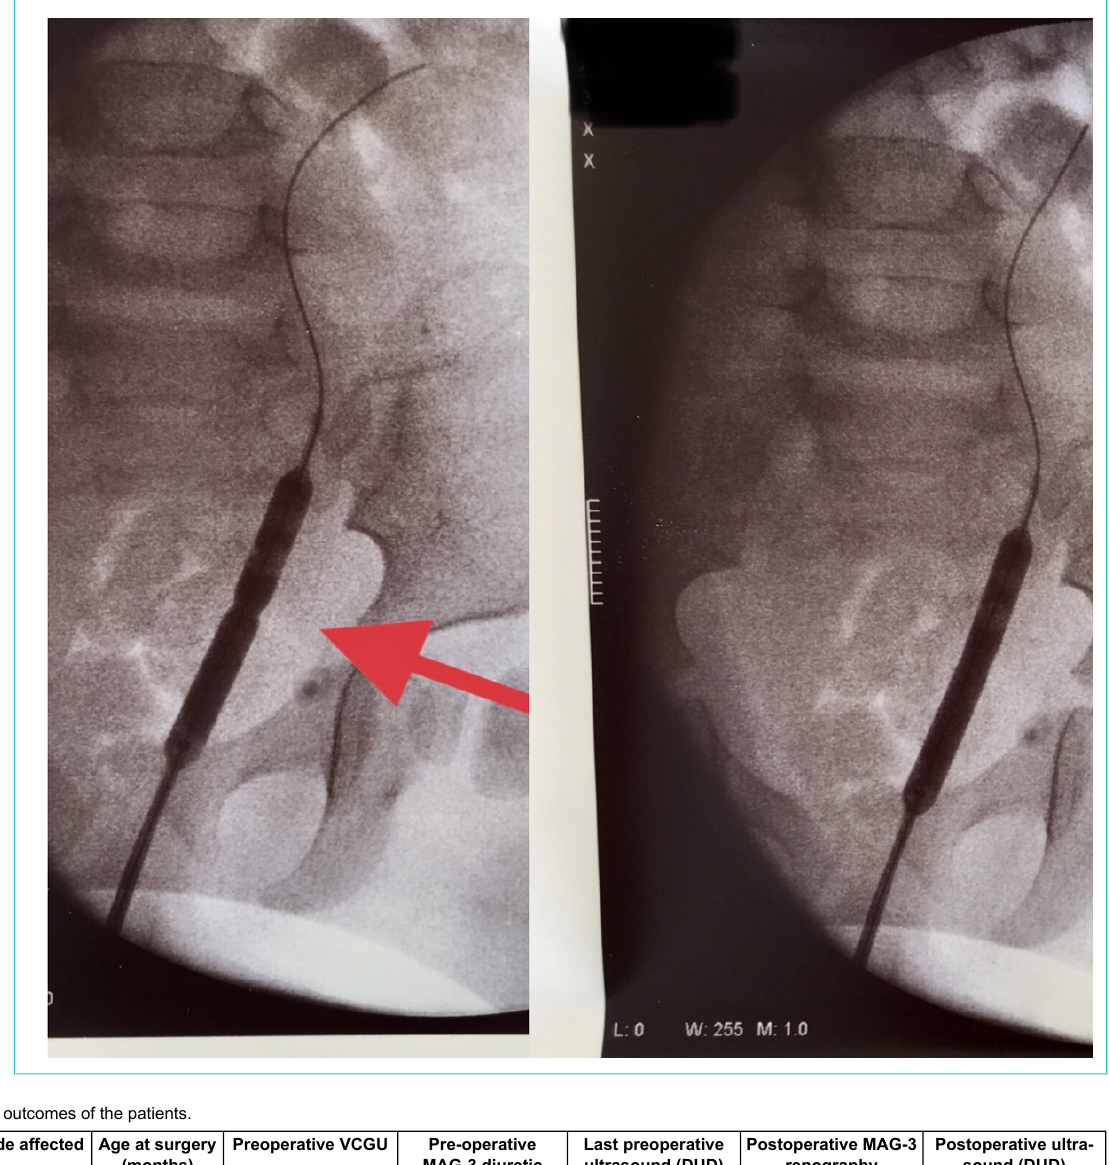
Figure 3: The inflated balloon shows the ring-like stenotic portion of the vesicoureteral junction that disappears after high-pressure balloon di- latation.